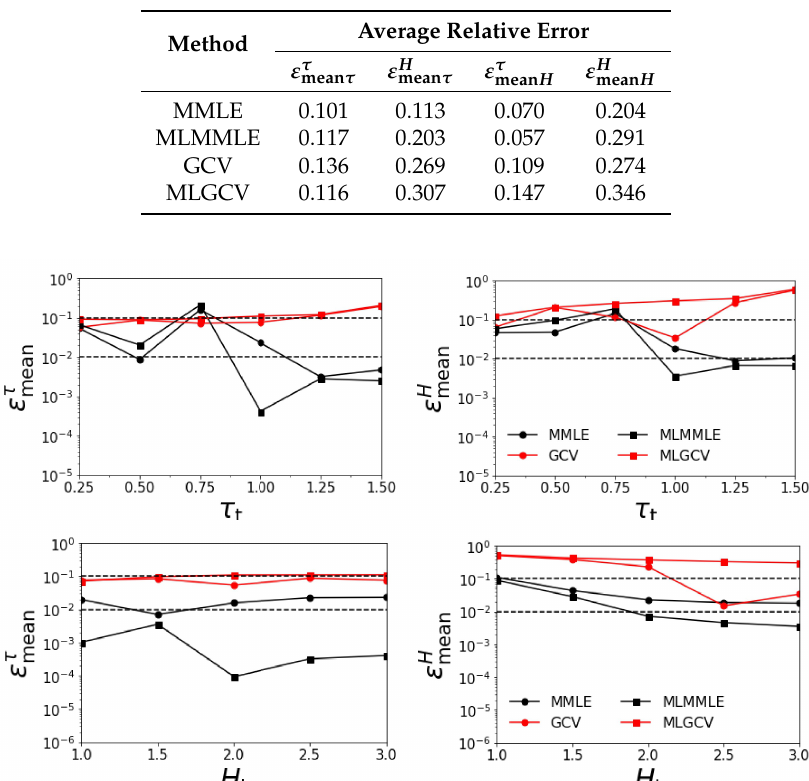
Table 5. Average relative errors for the results plotted in Figure 7.